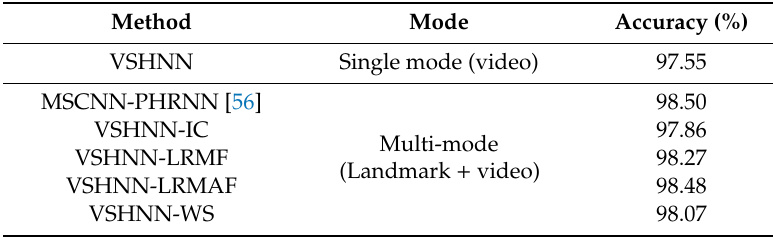
Table 12. Performance evaluation of multi-modal fusion for CK +